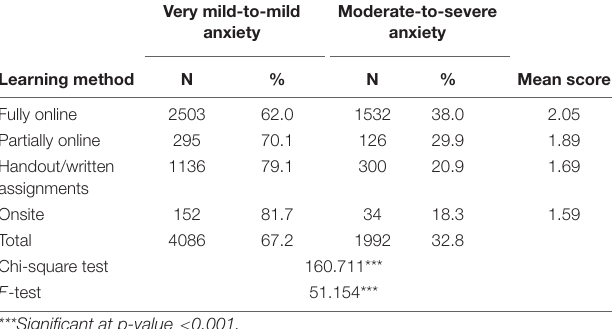
TABLE 2 | Cross-tabulation: learning method and anxiety level.